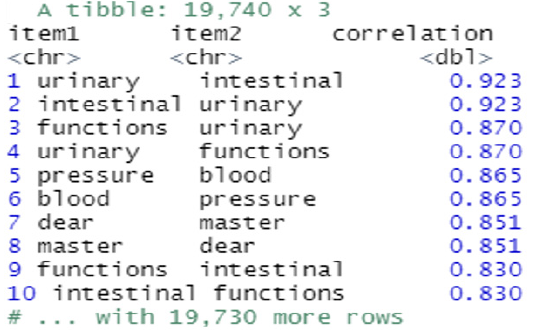
Figure 7. Correlation table between the symptomatic